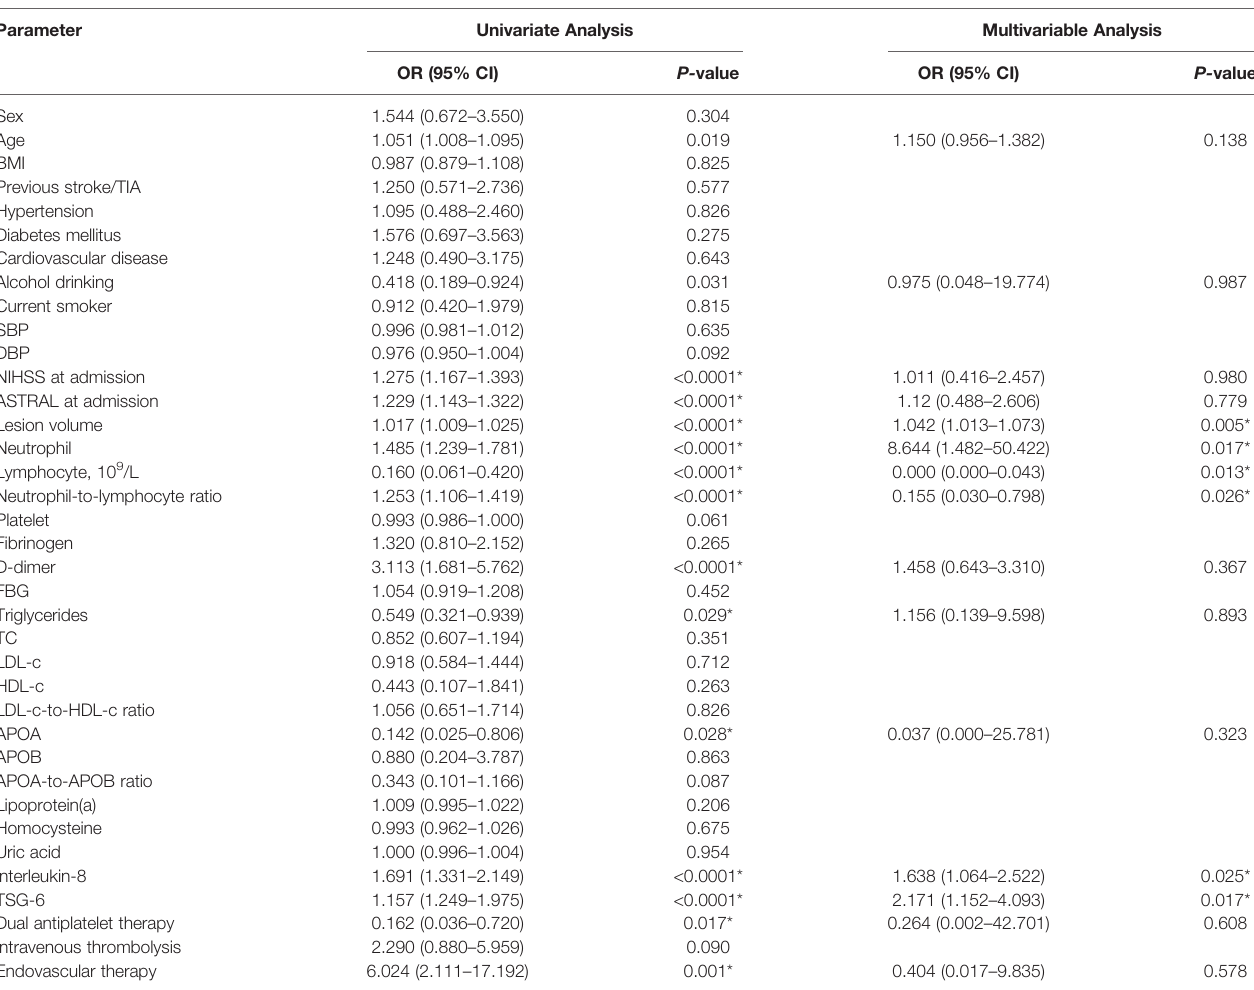
TABLE 2 | Logistic regression analysis for the 3-month